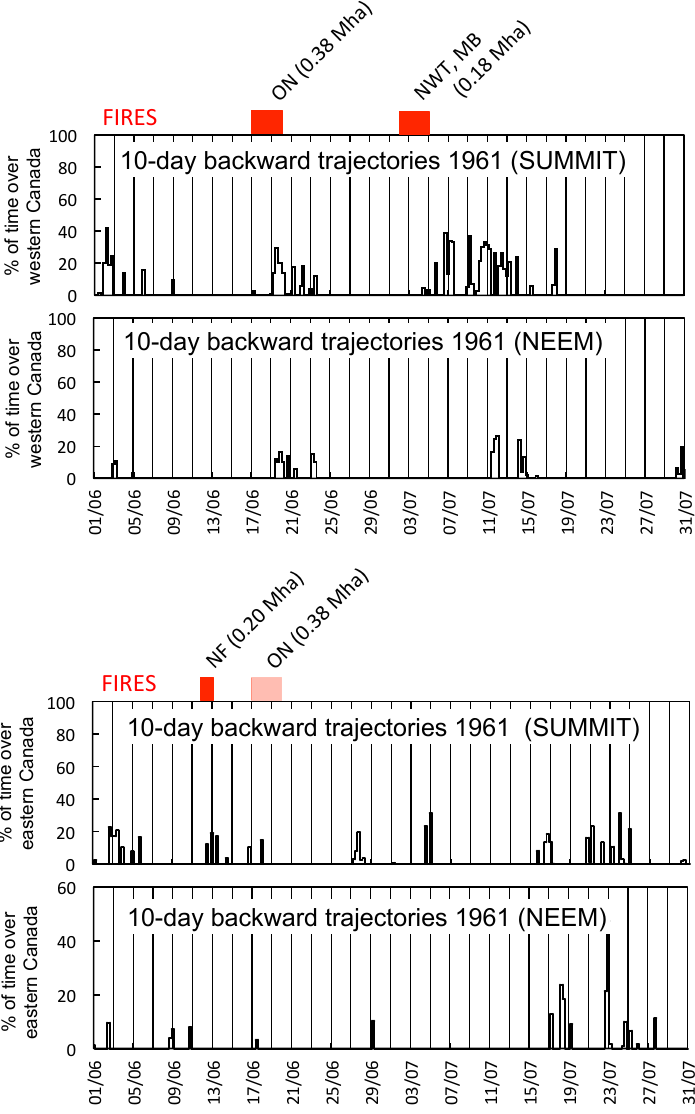
Figure 12. Fraction of time spent by air masses arriving at Summit and NEEM (10-day backward trajectories) at 500ma.g.l. and having traveled over a forested area of western (top) and eastern (bottom) provinces of Canada during the severe fire conditions of June/July 1961 (Fig. 10). Some of the largest fires are indicated on top of the panels (red symbols) with corresponding burned area: Ontario and Northwest Territories in the West, Newfoundland and Labrador in the east. The Ontario fire was located in the western portion of the province and we report the red symbol on both panels. Area burned data are from the Canadian National Fire Database (Sect.